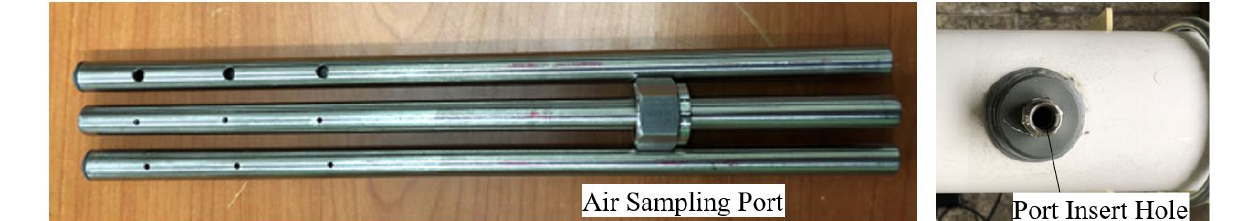
Figure 6. Picture of air sampling ports and port hole. Table 3. Specifications of the air suction holes of an air sampling port. Inflow Air Velocity, cm/s